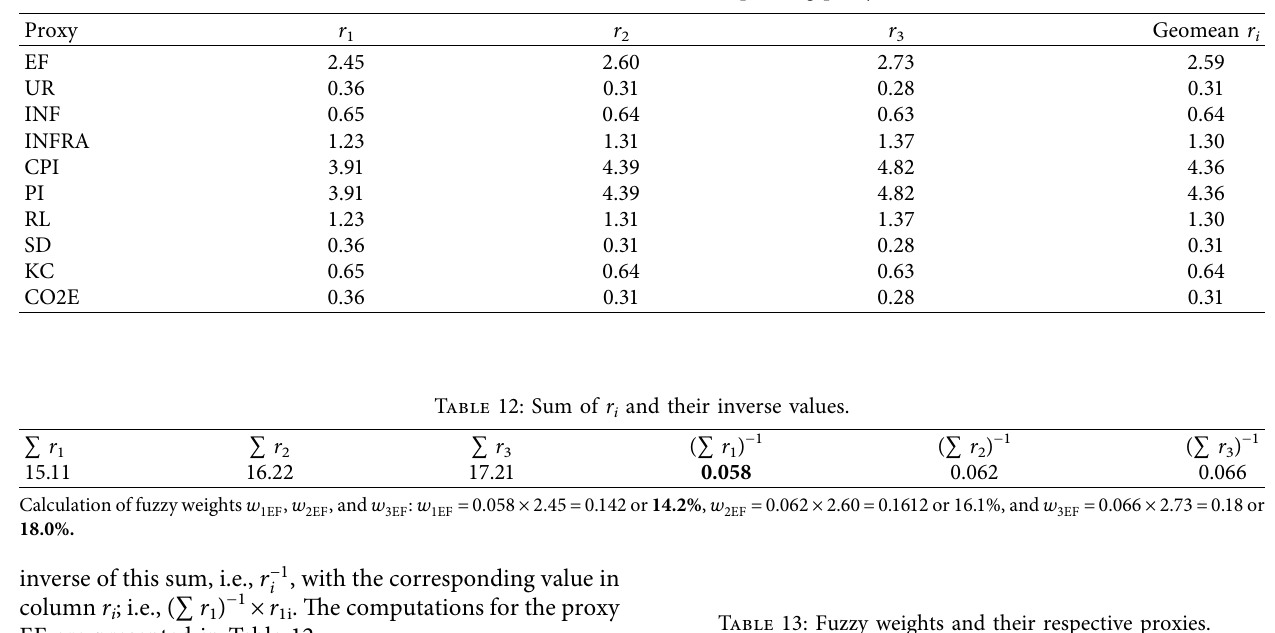
Table 11: Geomean r i and its corresponding proxy.